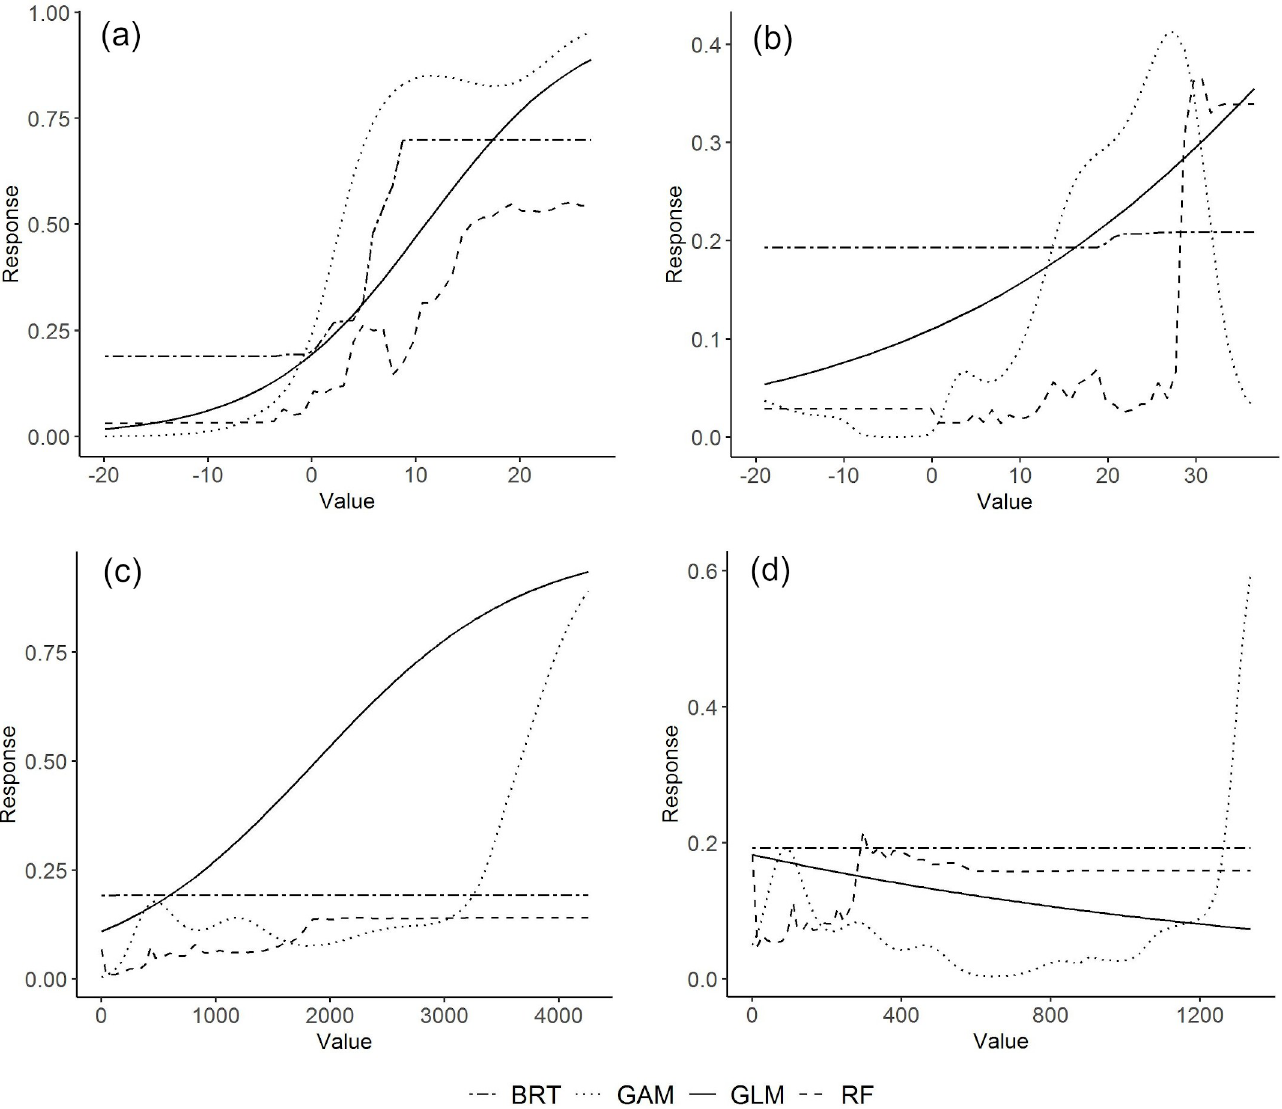
Fig 3. Response curves of predicted suitability for Aedes aegypti along the gradient of climatic predictor variables: a) minimum temperature of coldest month; b) mean temperature of wettest quarter; c) precipitation of wettest quarter; d) precipitation of driest quarter.